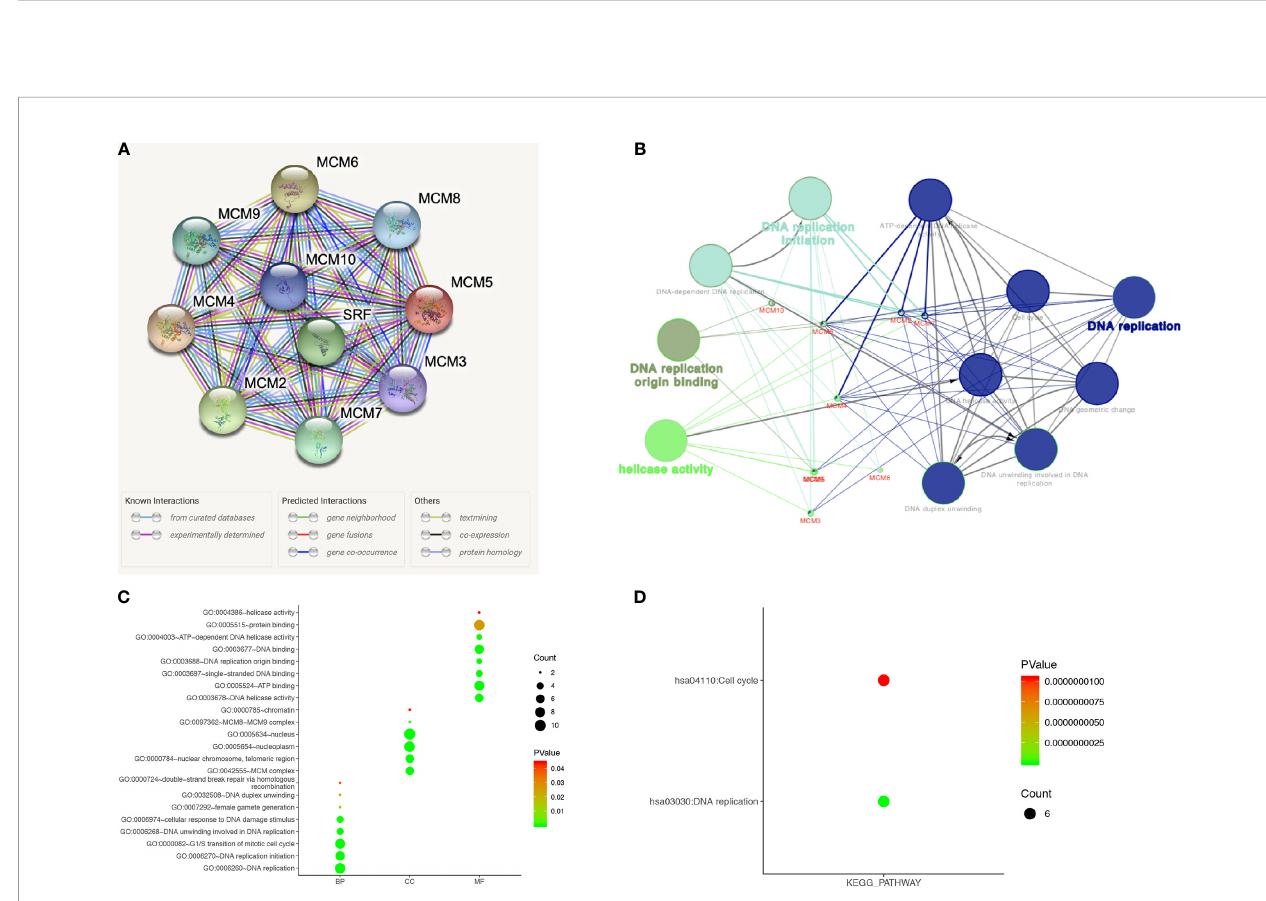
FIGURE 9 | Functions enrichment and signaling pathways analysis of the mutations in MCM s in SKCM patients. (A) A PPI network analysis of differentially expressed MCM s with STRING was conducted to show the close interactions among them. (B) The functional annotation analyses of MCM s were constructed using ClueGO, including DNA replication, DNA replication initiation, helicase activity, and DNA replication origin binding. ( C, D ) GO and KEGG pathway enrichment analyses of MCM s were performed using DAVID and visualized in bubble chart. The biological processes of MCM s were greatly enriched in DNA replication, G1/S transition of the mitotic cell cycle, DNA replication initiation, DNA unwinding involved in DNA replication, cellular response to DNA damage stimulus, and DNA duplex unwinding. Changes in cellular components were signi fi cantly enriched in the nucleus, nucleoplasm, nuclear chromosome, telomeric region, and MCM complex. As for molecular function, changes were mostly enriched in protein binding, ATP binding, DNA binding, DNA helicase activity, and single-stranded DNA binding. KEGG analyses revealed that MCM s were most involved in cell cycle and DNA replication (BP, biological process; CC, cellular component; MF, molecular